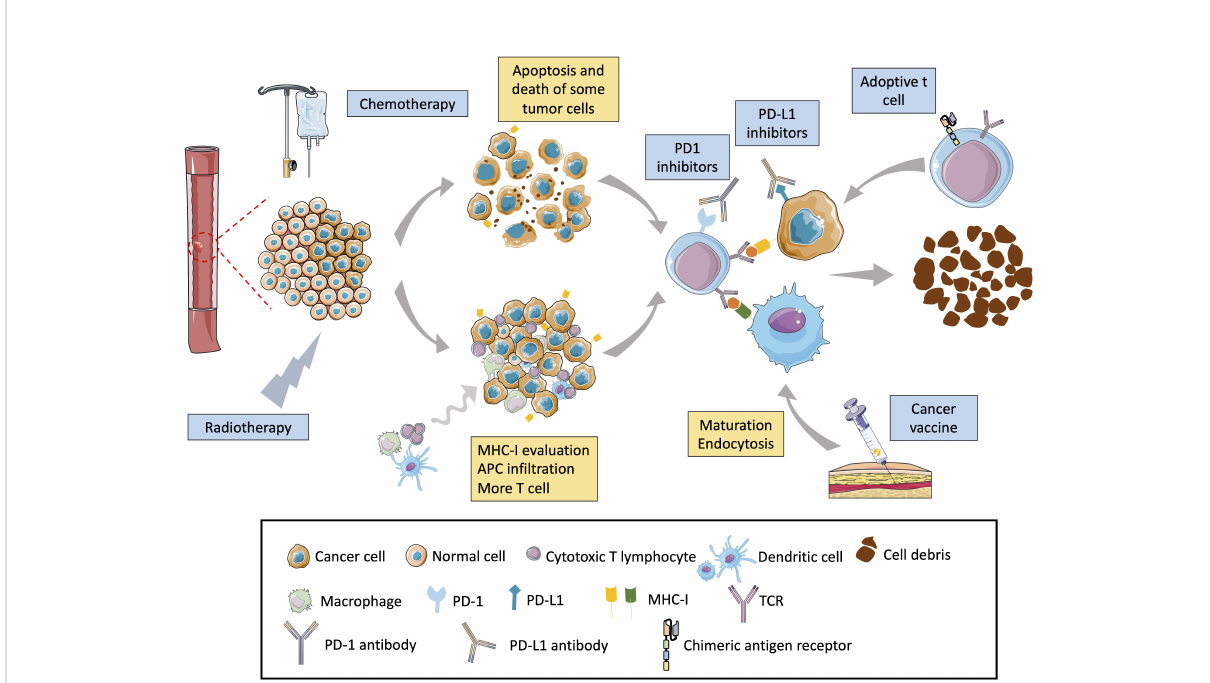
FIGURE 2 Mechanism of chemoradiation – immunotherapy combination in esophageal cancer. Chemoradiation can directly lead to the death of cancer cells by apoptosis, necrosis, and autophagy, promoting the release of tumor-speci fi c antigens by tumor cells and increasing the chances of immune cells fi nding cancer cells. Chemoradiation can also directly destroy the DNA of cells, causing cancer cells to produce neoantigens and triggering an immune response. In addition, chemoradiation can upregulate the expression of tumor MHC-I that can better present tumor- speci fi c antigens and enhance tumor visibility by cytotoxic T cells. Radiotherapy can modulate the tumor microenvironment, increase the tumor microenvironment, and promote the migration of cytotoxic T cells to the tumor. Radiotherapy also upregulates the PD-L1 expression level on the cancer-cell surface, enhancing the therapeutic effect of PD-L1